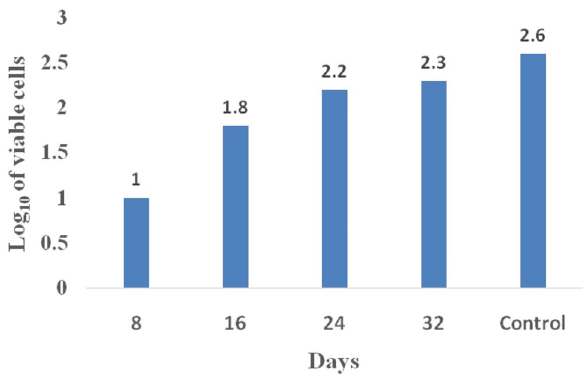
Fig. 1 Effect of the microplastics on soil microbiome structure.